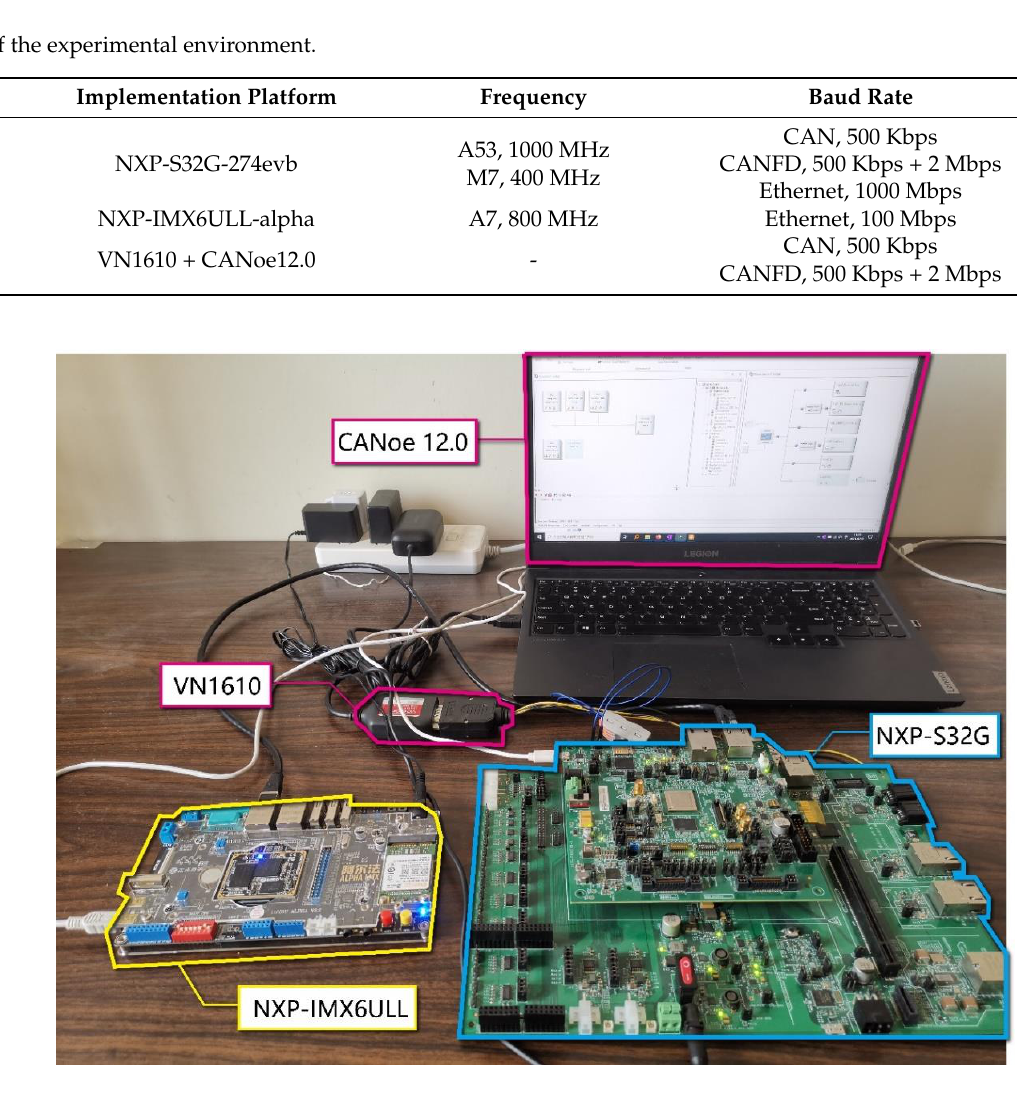
Figure 10. Experimental